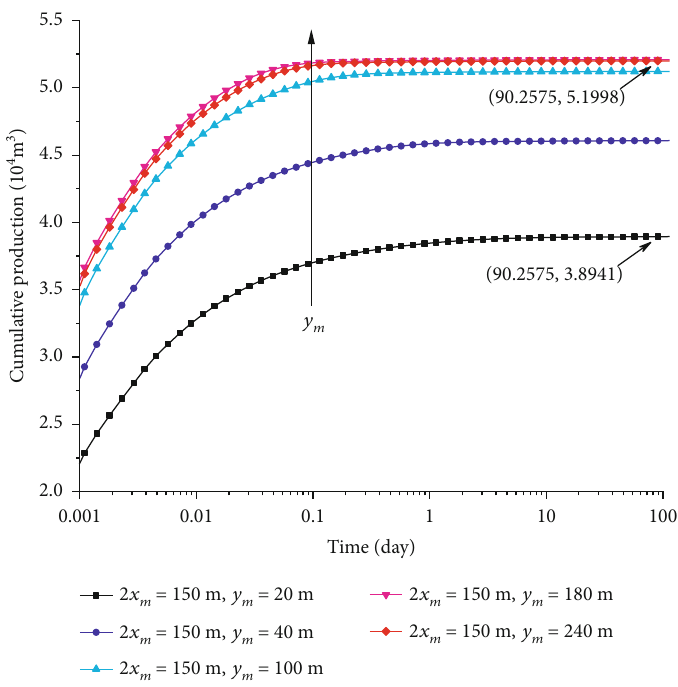
Figure 8: The e ff ect of SRV size on cumulative production (constant pressure).